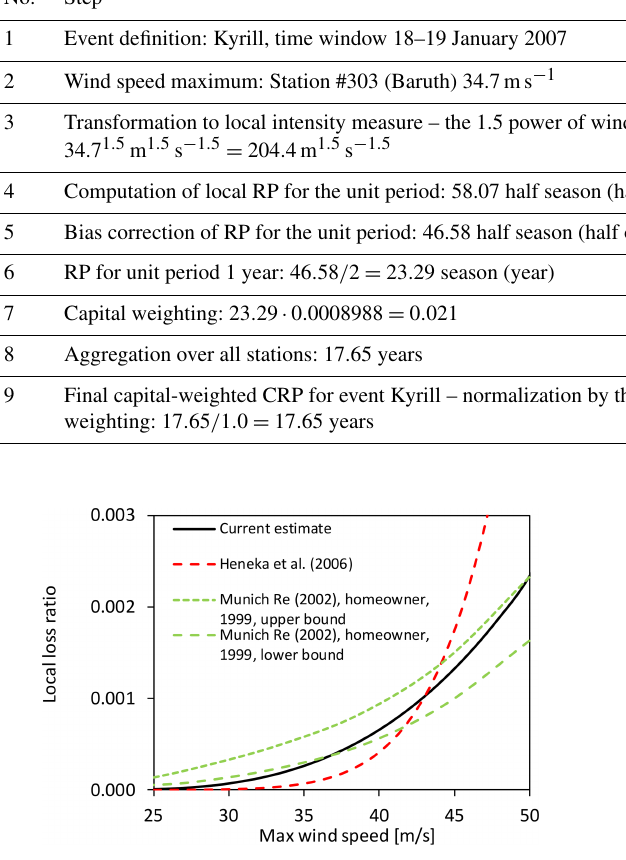
Figure 8. Vulnerability functions: current estimate with the av- erage of local parameters and previous estimates by Heneka and Ruck (2008) and Munich Re (2002) for residential